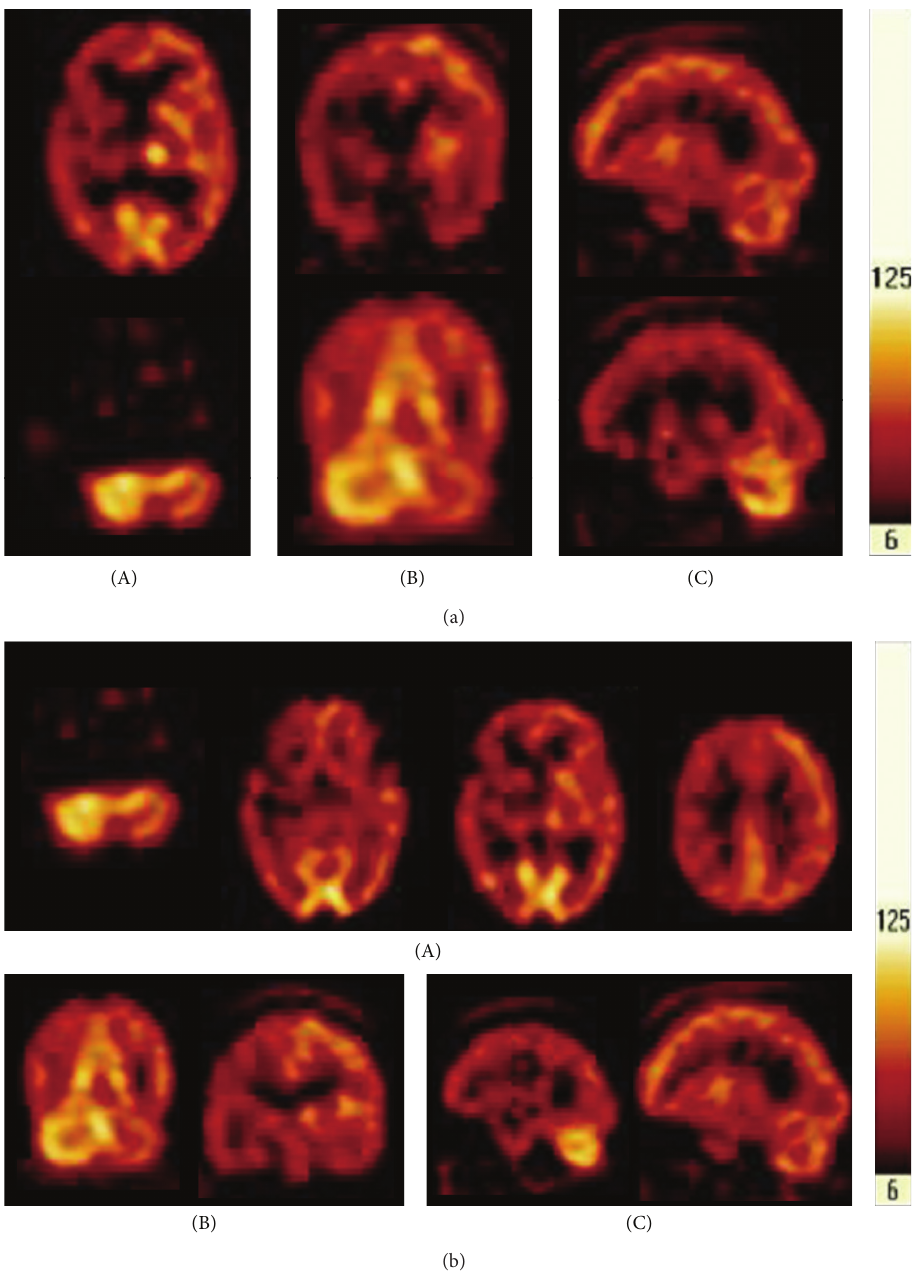
Figure 1: (a) The pictures of the brain SPECT. (A) Transverse view; (B) coronal view; (C) sagittal view. There is inhomogeneous perfusion in the cerebral cortex with relative decrease of uptake in right fronto-temporal-parietal, right temporal, and right parietal regions. The uptake in right basal ganglion and thalamus is decreased when compared with the left side. Remarkably, the uptake in left cerebellum looks lower than the right cerebellum, suggesting the presence of CCD. (b) The second examination of the brain SPECT. (A) Transverse view; (B) coronal view; (C) sagittal view. The pictures checked in the second time are similar to the first, and interestingly enough, CCD remains in the left